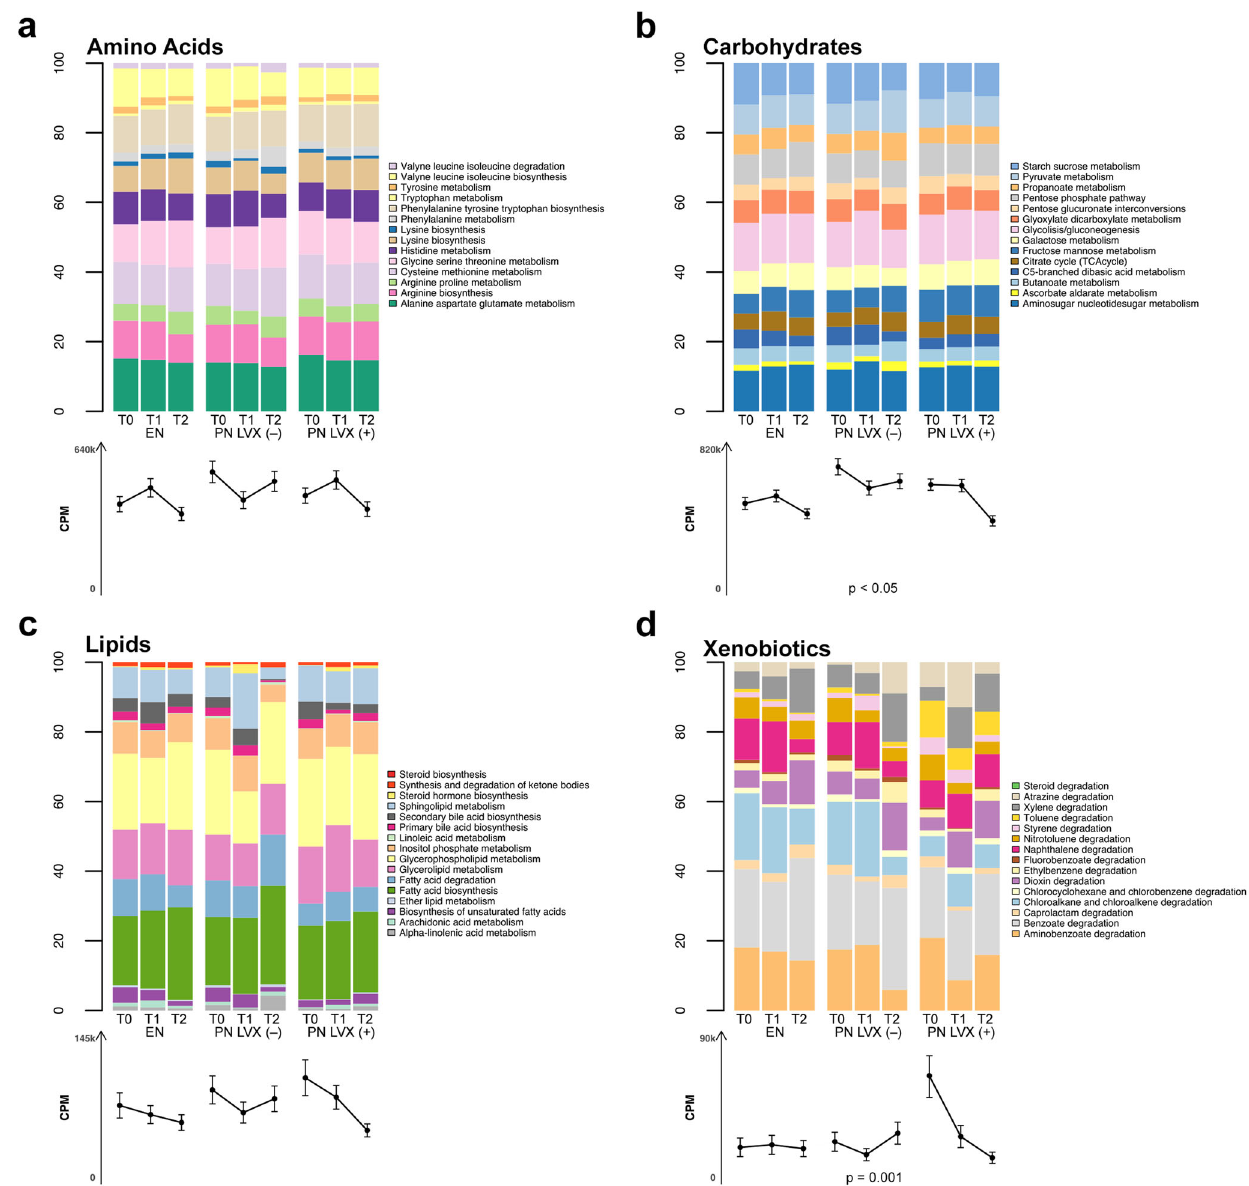
Fig. 4 The gut microbiome pro fi les of pediatric HSCT patients receiving PN and LVX prophylaxis are associated with altered carbohydrate and xenobiotic metabolic potential. On top of each fi gure, bar plots show the KEGG pathway classi fi cation of identi fi ed Kos divided by amino acid ( a ), carbohydrate ( b ), lipid ( c ), and xenobiotic ( d ) metabolism, represented as the mean relative contribution of each pathway to the total CPMs (copies per million) assigned to a given metabolism. Below each bar, the average number of normalized reads assigned to each metabolism is represented (CPM ± standard error of the mean). Data are shown for each patient group (PN combined with LVX prophylaxis — PN LVX ( + ) vs PN alone — PN LVX ( – ) vs EN alone — EN) before (T0) and at 2-time points after HSCT (T1 and T2). Signi fi cant differences among groups are shown (Kruskal – Wallis test with FDR correction). n = 10 biologically independent samples for each time LVX ( + ) patients were overall distinguished by higher relative abundances of the Klebsiella triad and potential pathobionts R.